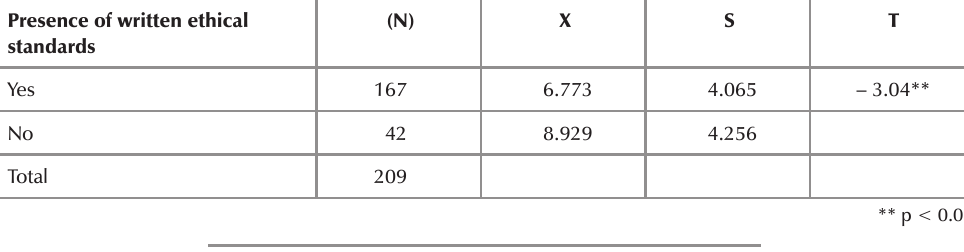
Relationship between written ethical standards and unethical behaviour using the mean score Presence of written ethical